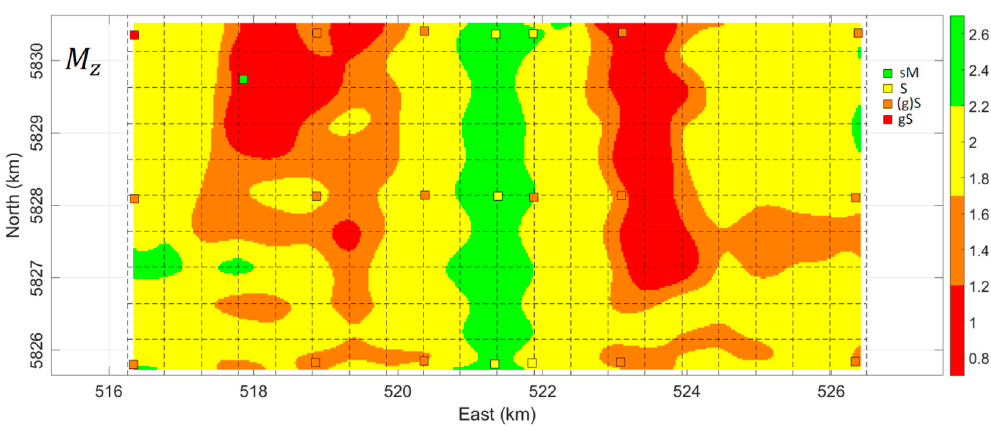
Figure 11. Smoothed maps of inverted mean grain size M z along with Folk classes of grab samples when spectral strength w 2 and volume scattering parameter σ 2 were kept fixed to their average values.